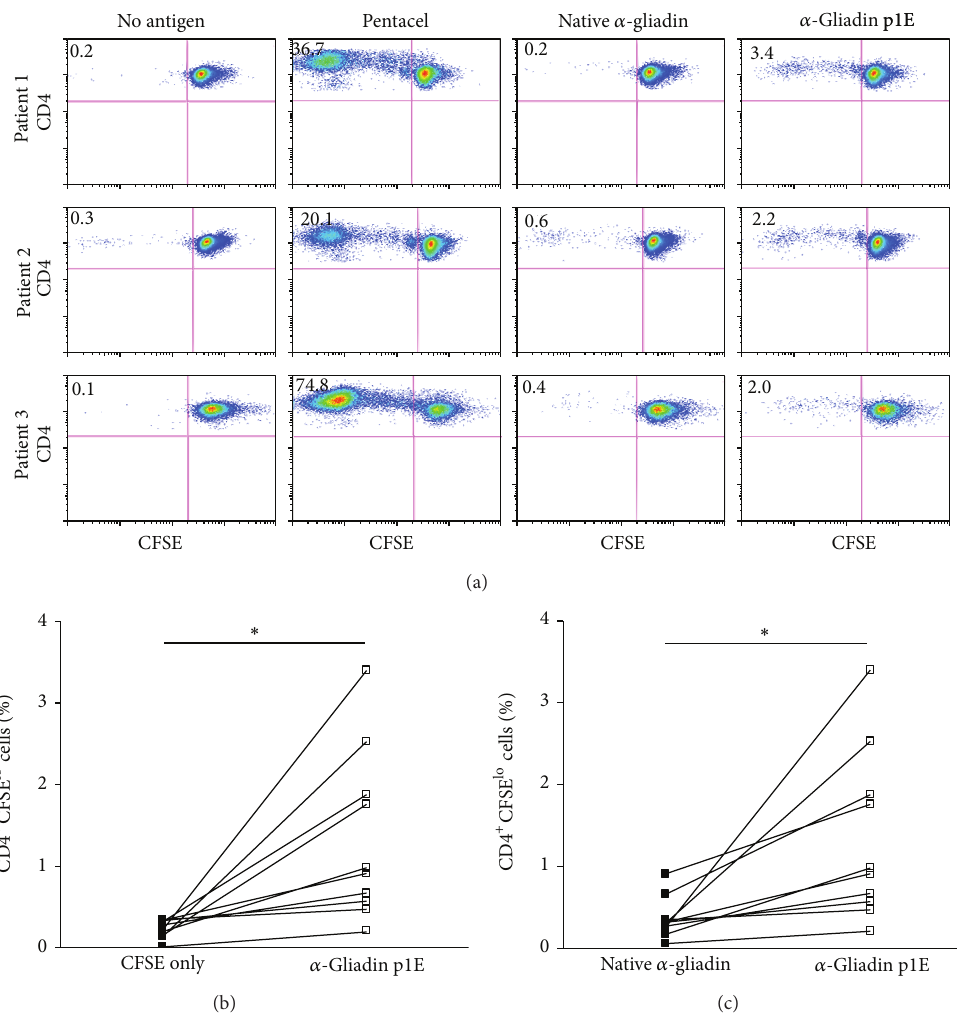
Figure 3: Proliferation of unfractionated PBMCs with 𝛼 -gliadin peptides. (a) Representative data from three newly diagnosed Celiac subjects with 7-day CFSE proliferation assays. CD4 T cells proliferate in response to the 𝛼 -gliadin p1E deamidated peptide without the in vitro addition of cytokines. (b) Summary data of proliferative responses comparing CFSE only (no antigen background) to the 𝛼 -gliadin p1E peptide. (c) Proliferation of native 𝛼 -gliadin to the 𝛼 -gliadin p1E deamidated peptide. ∗ 𝑃 < 0.01 using a paired 𝑡 -test. Pentacel (positive control) is a childhood vaccine containing immunogens directed against diphtheria, tetanus, pertussis, poliomyelitis, and Haemophilus influenzae type